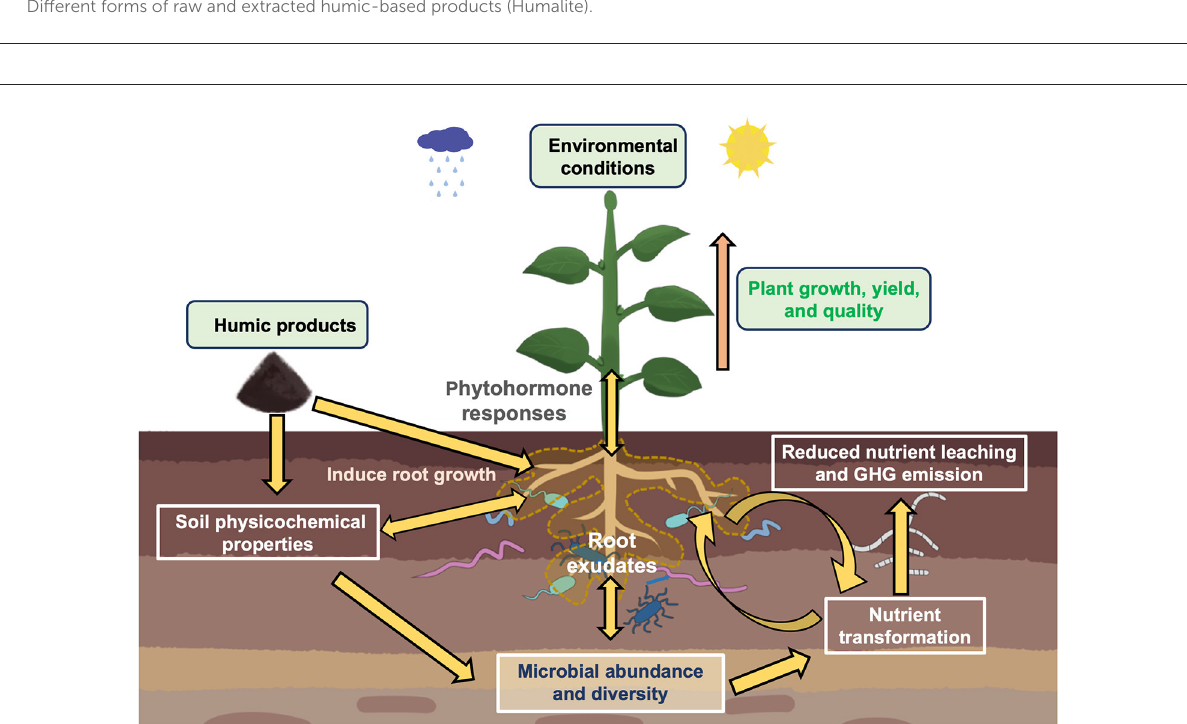
FIGURE2 An illustration showing complex interactions determining impacts of humic-based products (HPs) application in agricultural soil. Multiple factors shape the microbial community assembly and functioning, such as sources of humic-based products and various biotic and abiotic factors (crop species, soil environmental parameters, microclimatic conditions, etc.). HPs application impacts the soil (physicochemical properties) and plant (root growth, root exudates, phytohormonal responses, shoot growth) and subsequent effects on microbial community composition and functions, such as soil nutrient transformations, a crucial soil ecosystem process for plant growth and